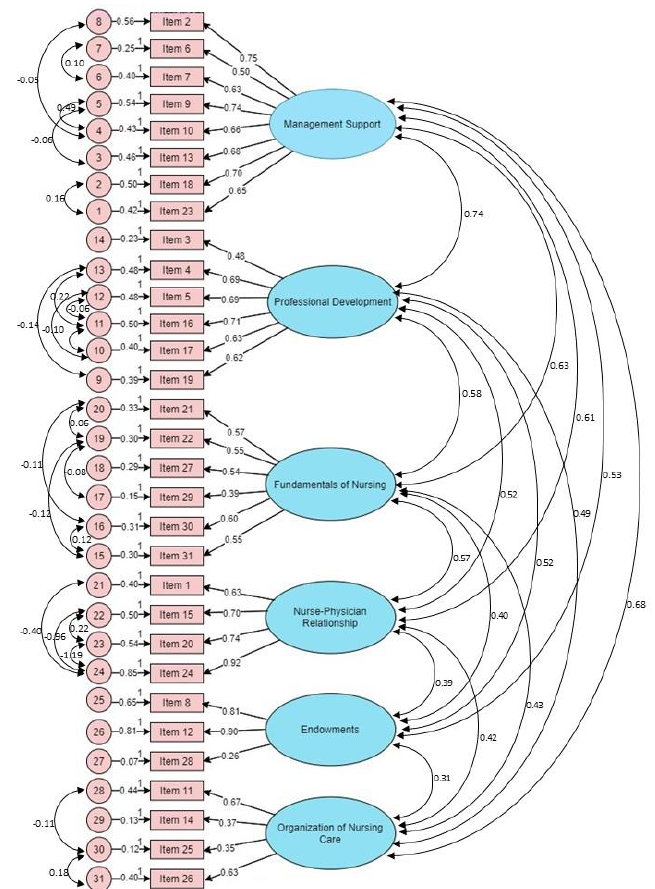
Figure 1. Six-factor model of Nursing Work Index-R in